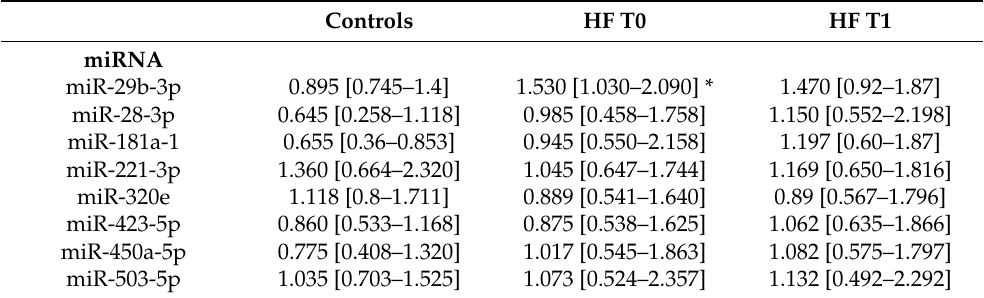
Table 2. Levels of validated miRNAs in control subjects and HF patients at baseline (T0) or at follow-up (T1).